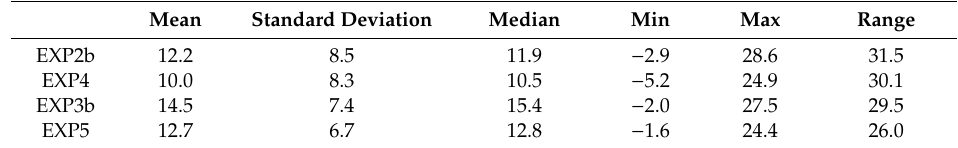
Table 22. TS ( ◦ C) (0–10 cm) simulated by UTOPIA and NOAH, initialized with GLDAS, at the CO station.